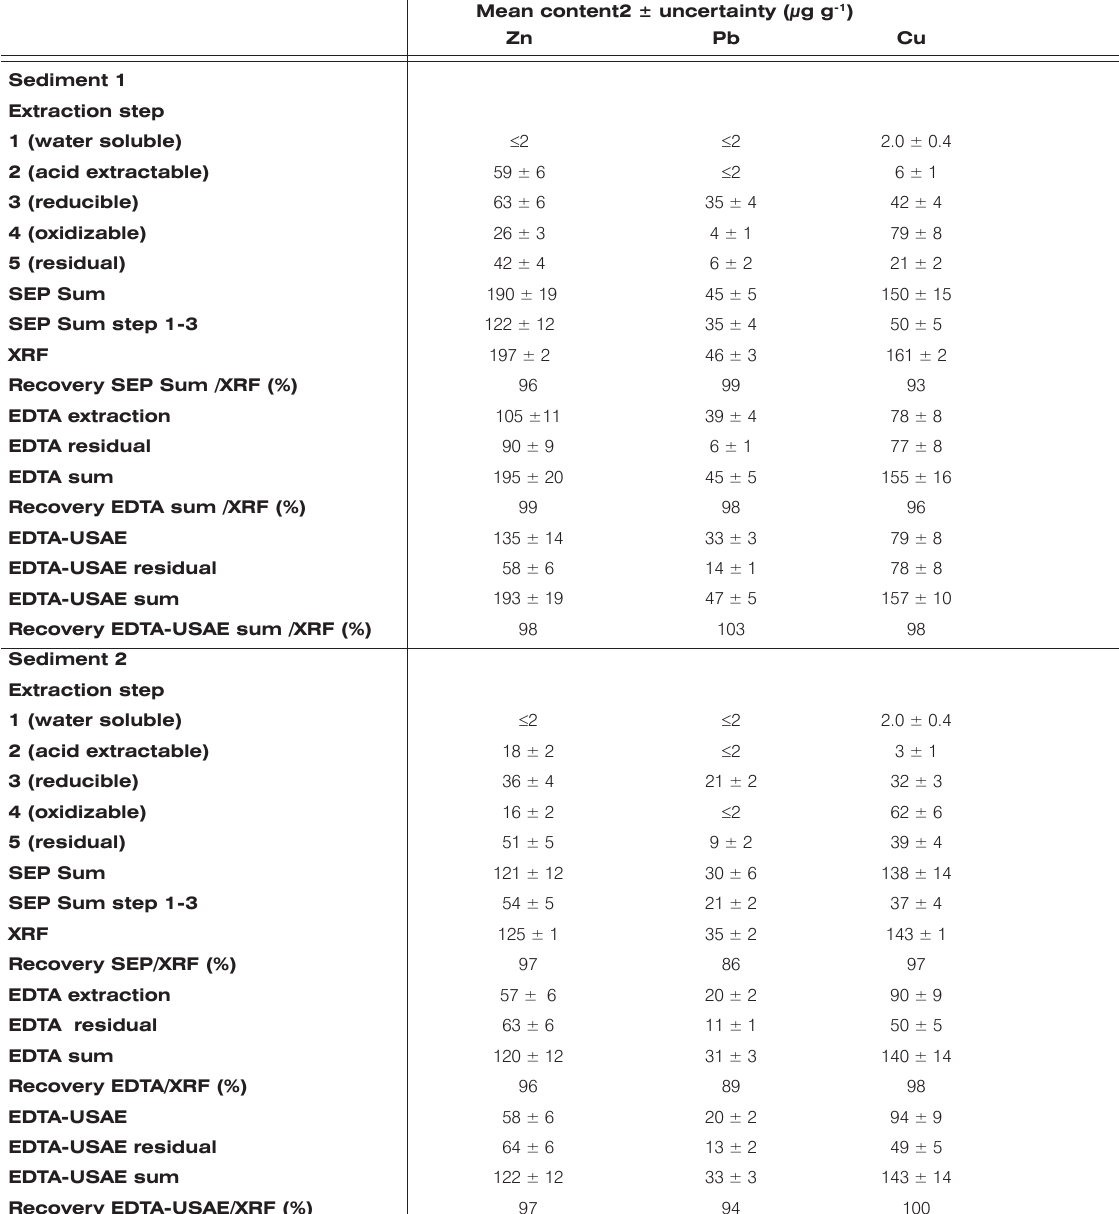
Table 3. The comparison of the Zn, Pb and Cu determination after five-step SEP, after conventional and ultrasonically assisted single-step (EDTA) extraction procedures, and the results of total content analyses performed by